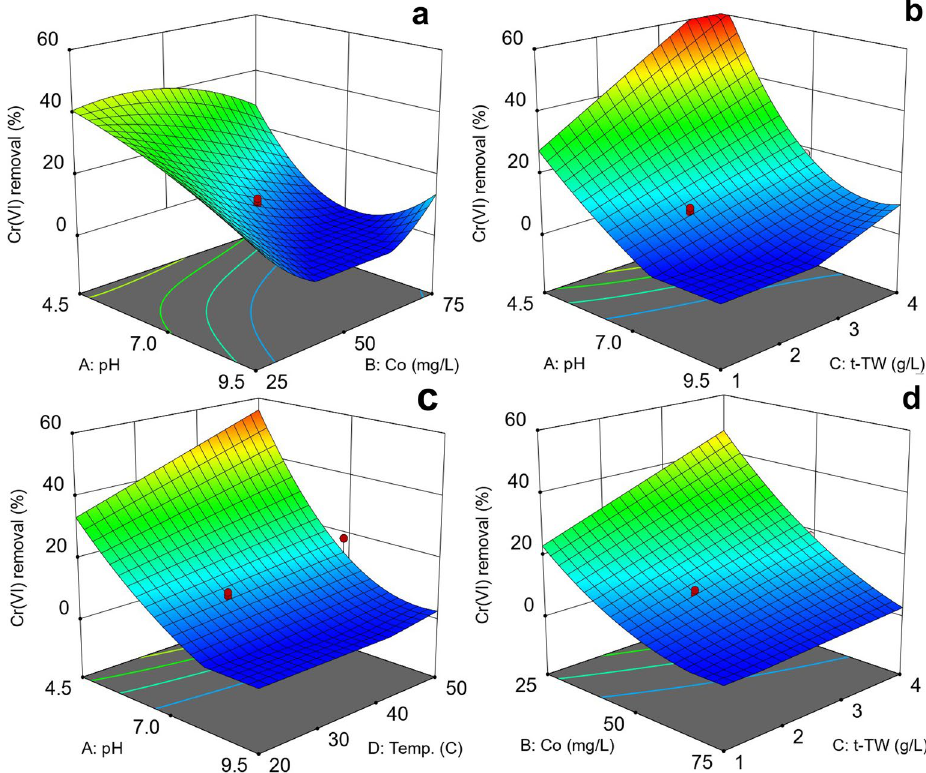
Figure 5. Combined effects of factors on Cr(VI) adsorption removal from water: ( a ) pH and initial Cr(VI) concentration at a t-TW dosage of 2 g L −1 and a temperature of 30 °C, ( b ) pH and t-TW dosage at an initial Cr(VI) concentration of 50.5 mg L −1 and a temperature of 30 °C, ( c ) pH and temperature at an initial Cr(VI) concentration of 50.5 mg L −1 and a t-TW dosage of 2 g L −1 , and ( d ) initial Cr(VI) concentration and t-TW dosage at a pH 7 and a t-TW dosage 2 g L −1